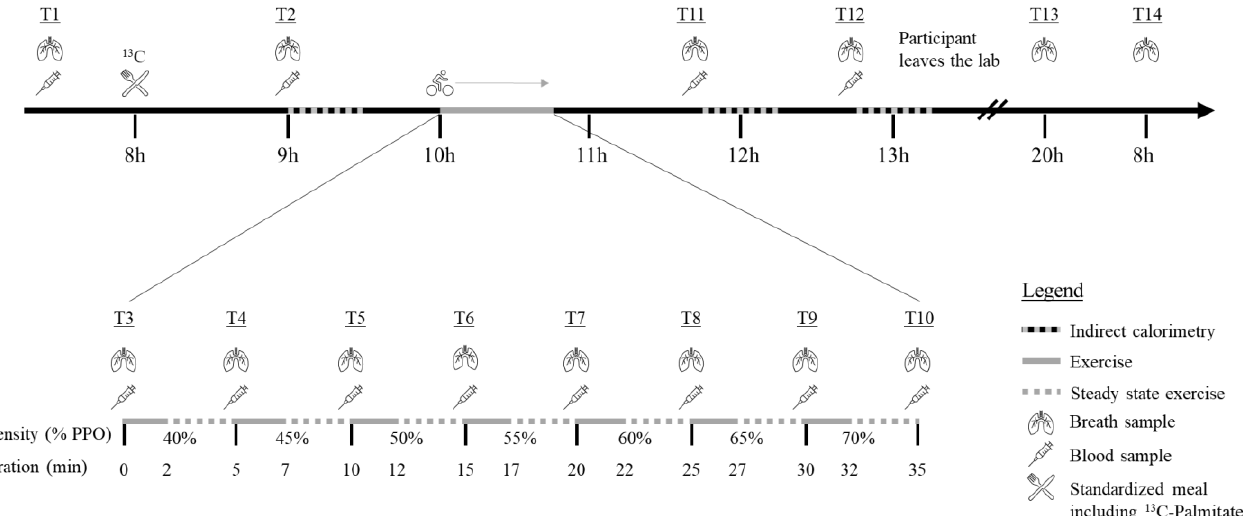
Figure 1. Experimental day % PPO = Percentage of Peak Power Output; min = Minutes; = Indirect calorimetry; = period of exercise; = steady state exercise; = breath sample; = blood sample; = Standardized meal including 13 C-Palmitate.